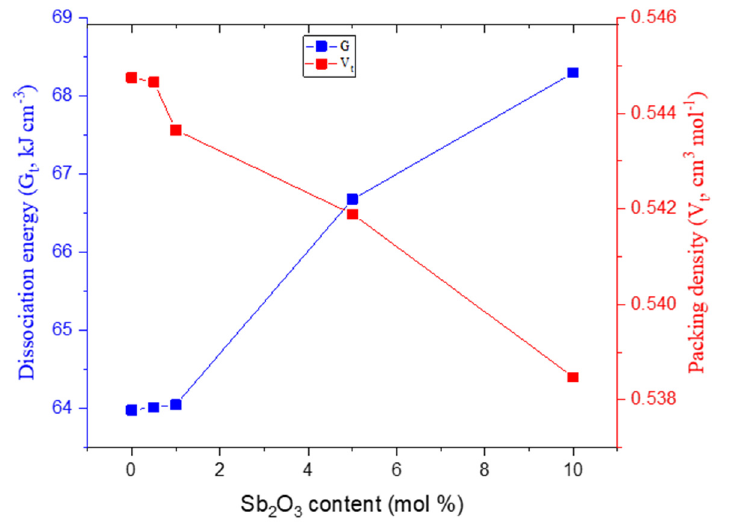
Figure 2. Variation of the dissociation energy per unit volume and the packing density of the studied glasses as a function of Sb 2 O 3 contents. Table 2. The mechanical properties of the investigated glasses.